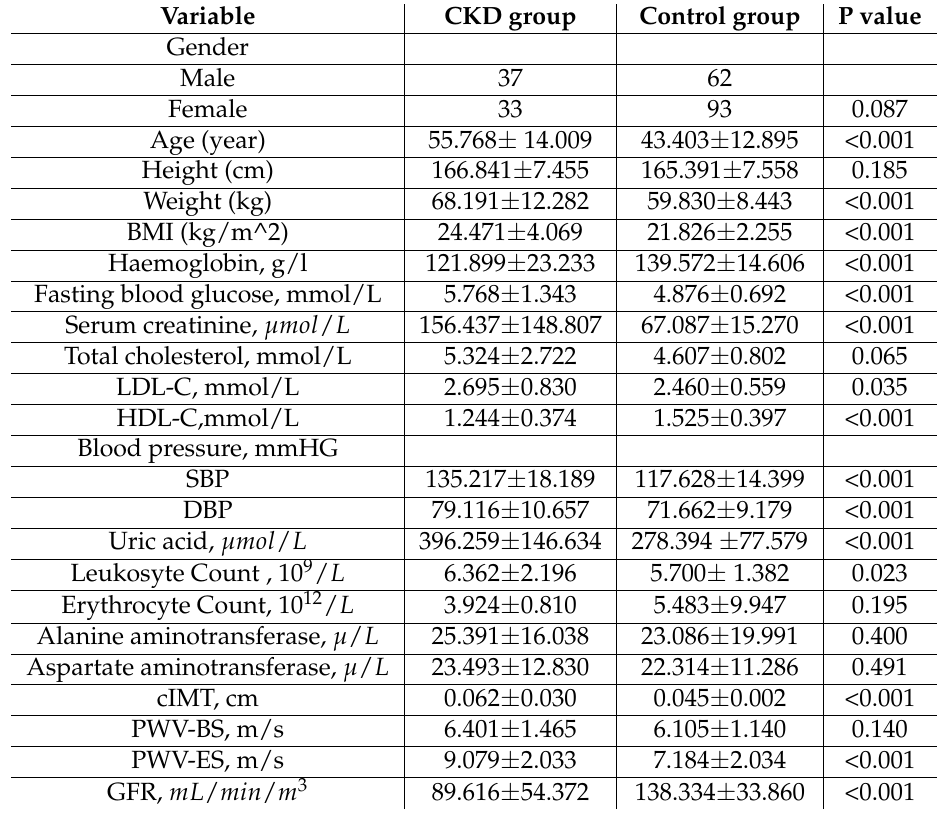
Table 1. Summary of variables